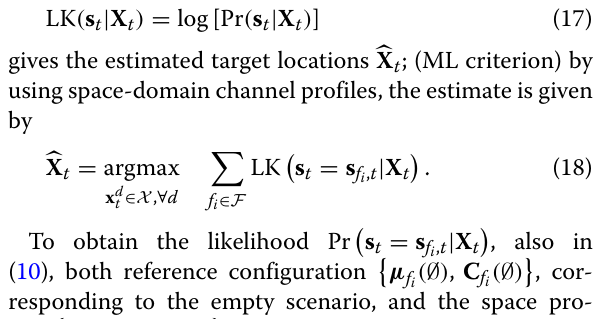
(cid:2) j f 2 , f 25 versus all 1 , (cid:2) 9